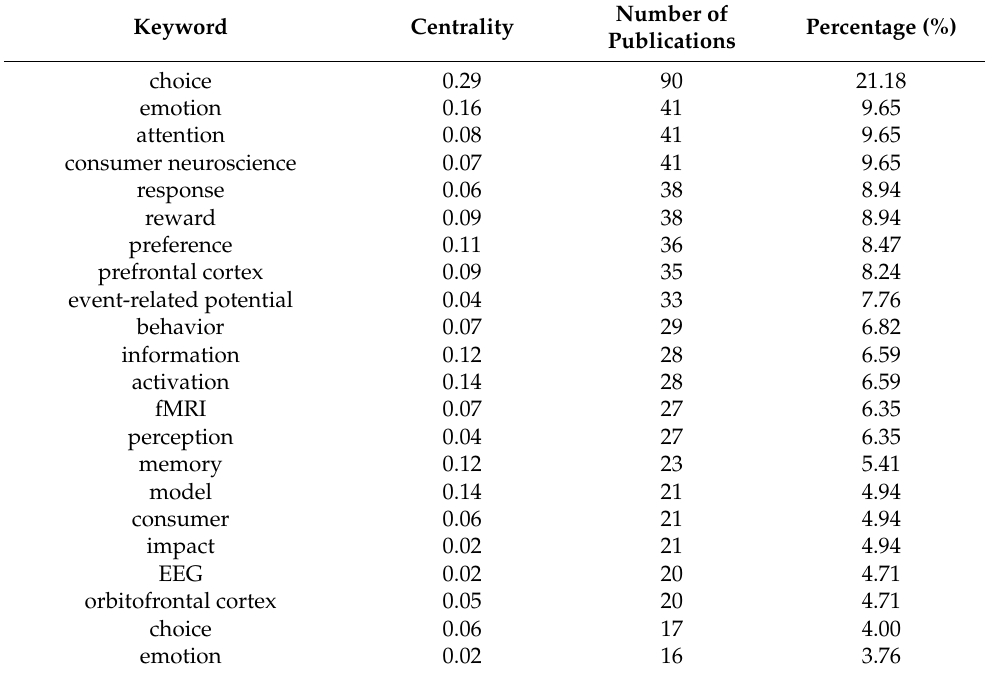
Table 2. Descriptive statistics for